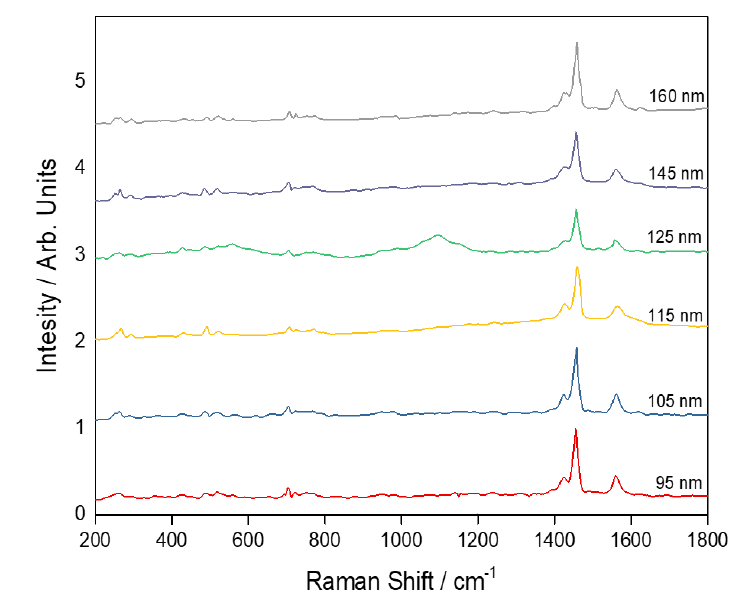
Figure 7. Raman spectrum of C 60 in gold cavity excited with 784 nm.